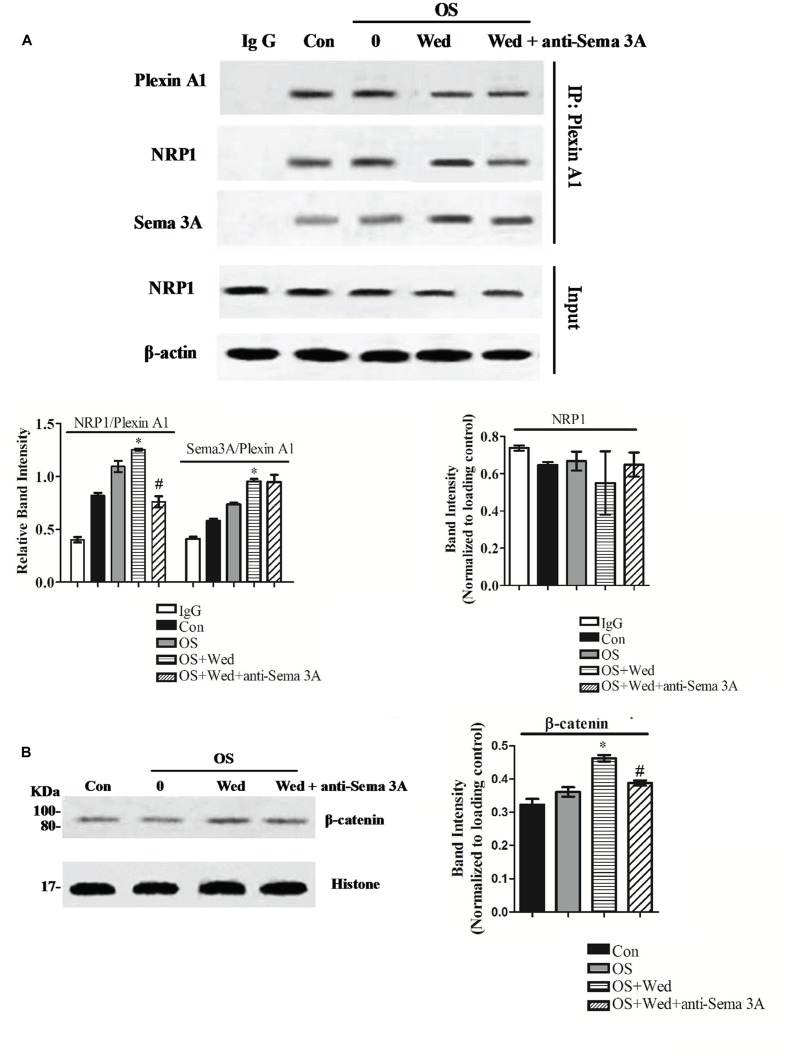
Effect of wedelolactone on the formation of Sema3A/NRP1/PlexinA1 complex and nuclear accumulation of β-catenin in BMSC. BMSC were seeded in 10-cm plate and treated with or without 2 μg/ml wedelolactone for 9 days. The cells were lysed and subjected to coimmunoprecipitation assays (A) or Western blot assays (B). Data are expressed as mean ± SEM of three independent experiments. ∗P < 0.05 compared with OS-treated control. #P < 0.05 compared with wedelolactone-treated cells.